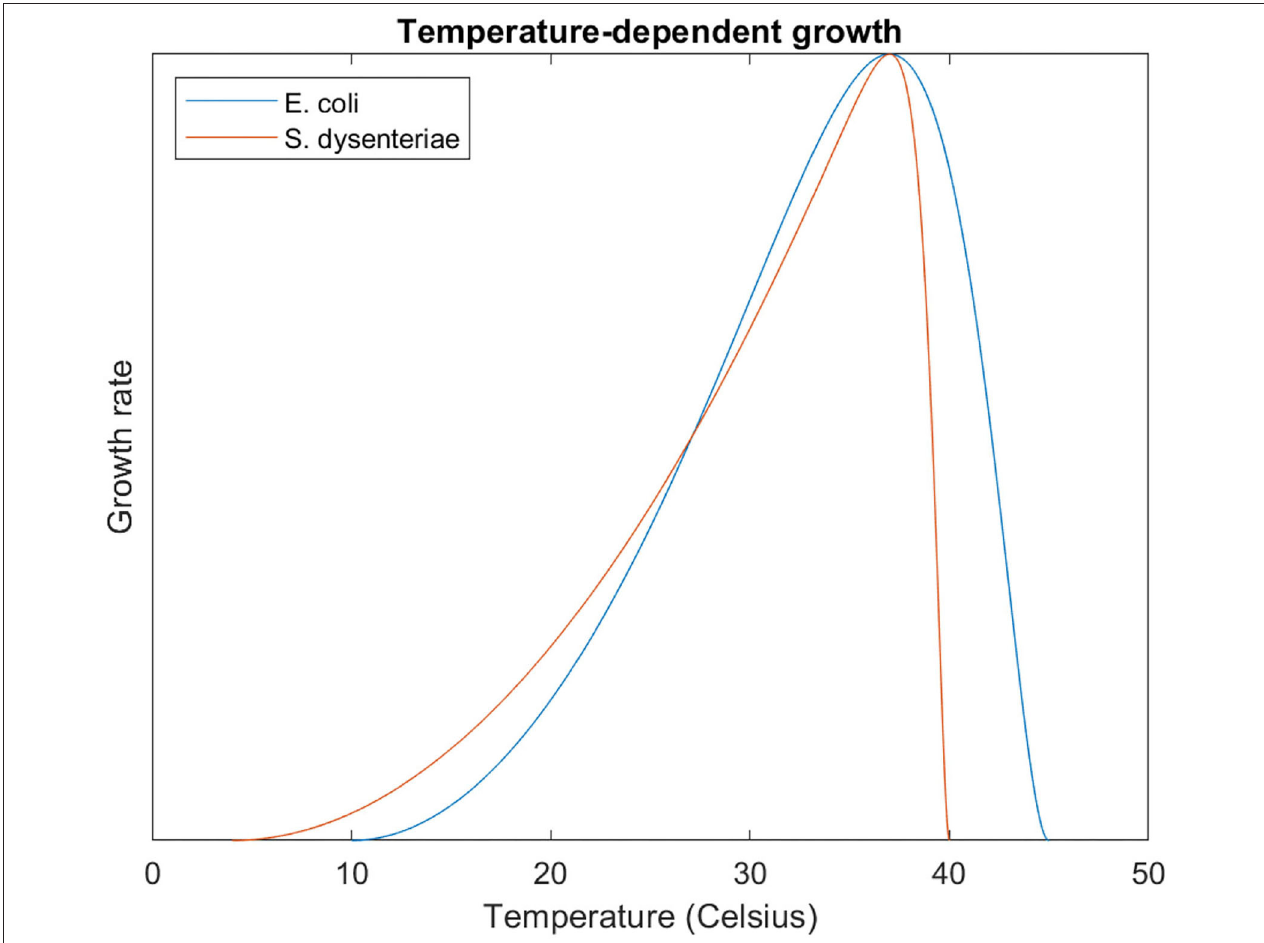
FIGURE 2 | S. dysenteriae and E. coli temperature dependent growth curves, modelled with the modified Ratkowsky equation. Note the much steeper relative decline in growth for S. dysterentiae at temperatures > 37 ◦ C.